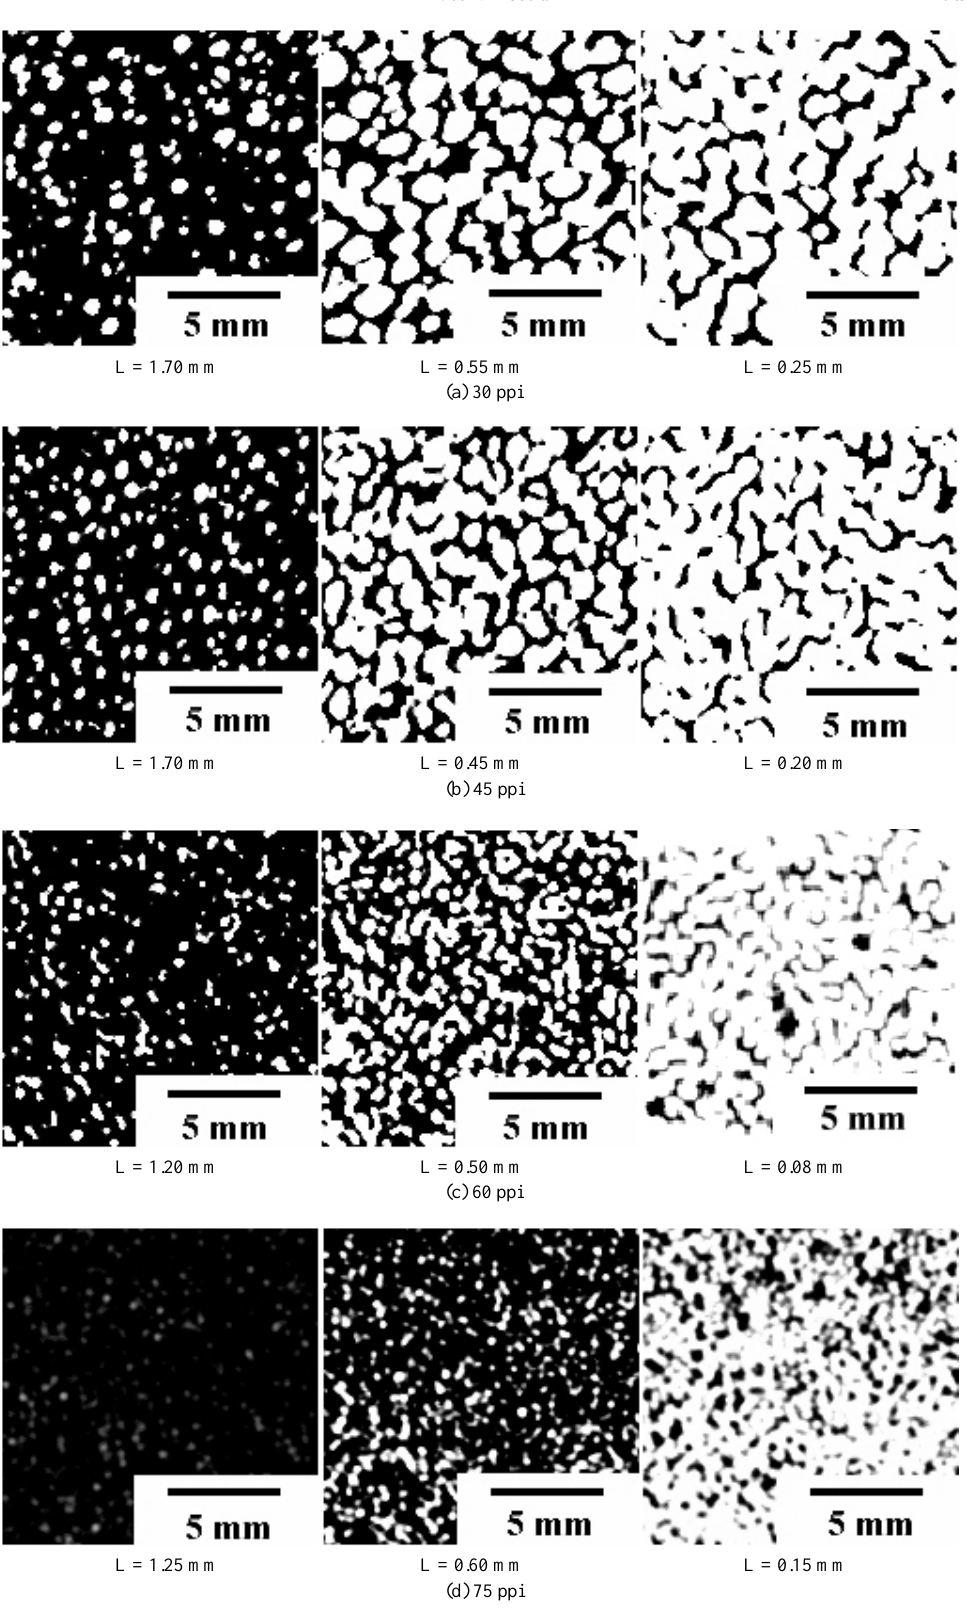
Figure 2. Image patterns for ceramic foam slices of different thickness (L). ** Image obtained by